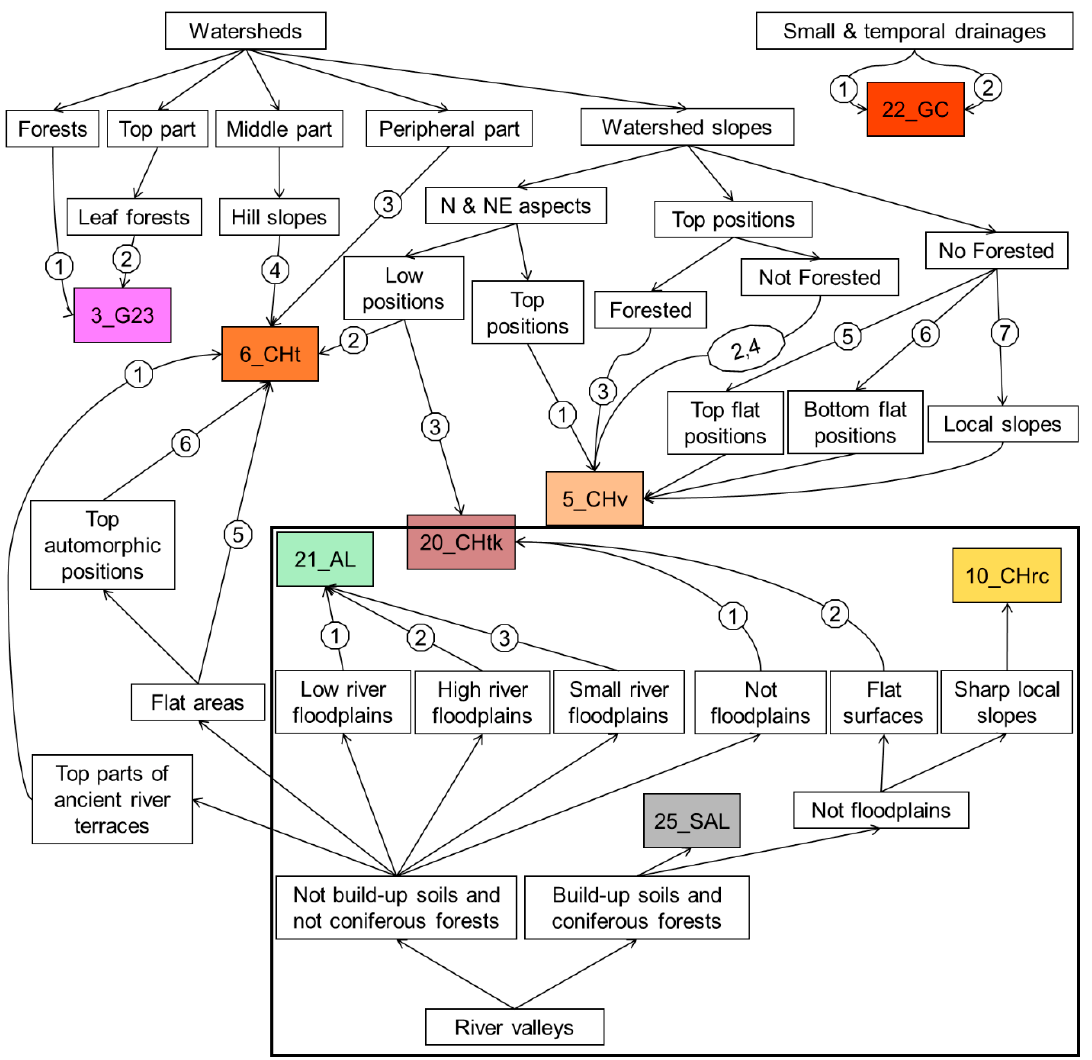
Figure 9. The qualitative decision tree with the numbers of rules from the quantitative decision tree (in the square—the part of the tree that was expertly corrected).